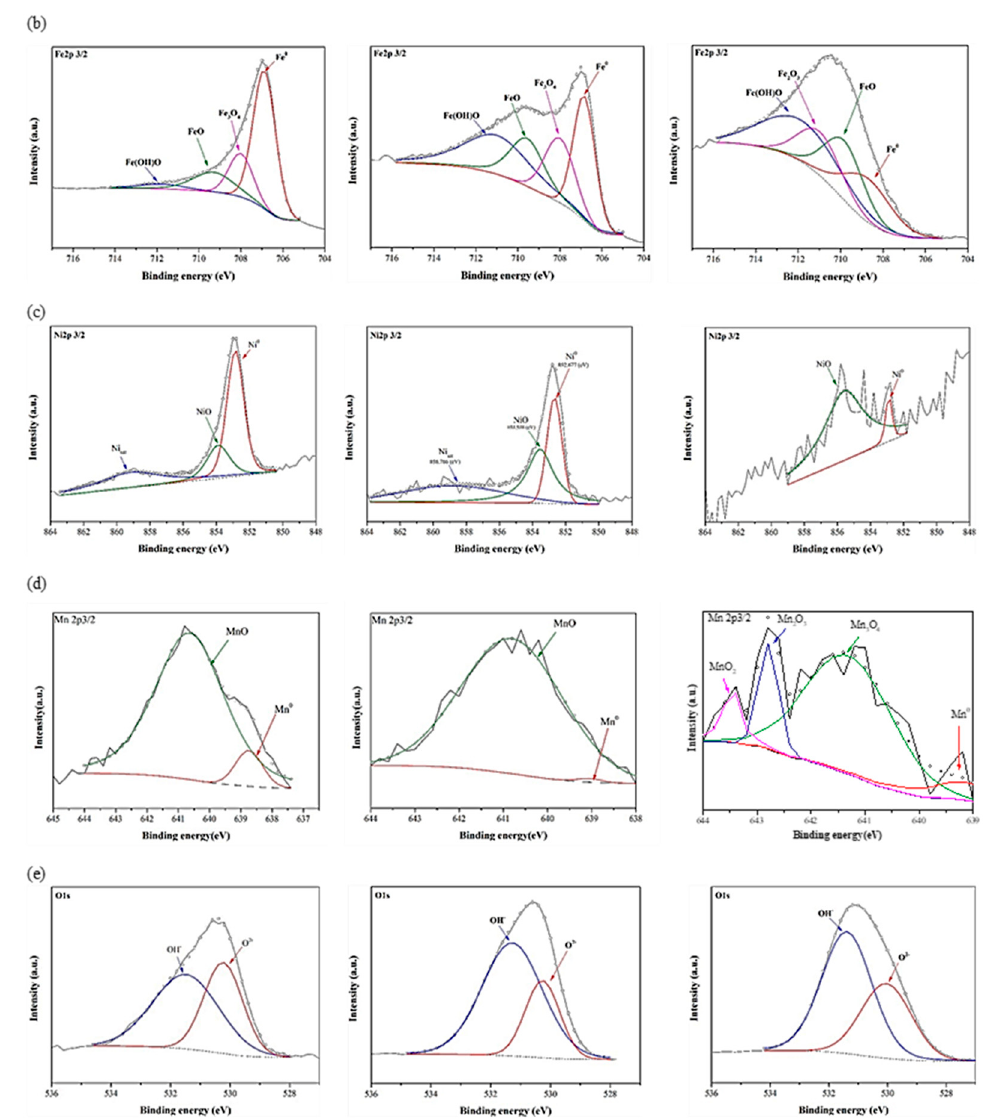
Figure 8. High resolution XPS spectra of the passivation films formed in the air, at E corr1 ( − 0.35V) (Ag/AgCl) and 0.6 V(Ag/AgCl) in 0.5 M H 2 SO 4 AAS. ( a ) Cr 2p 3/2 , ( b ) Fe 2p 3/2 , ( c ) Ni 2p 3/2 , ( d ) Mn 2p 3/2 and ( e ) O 1s on the surface of